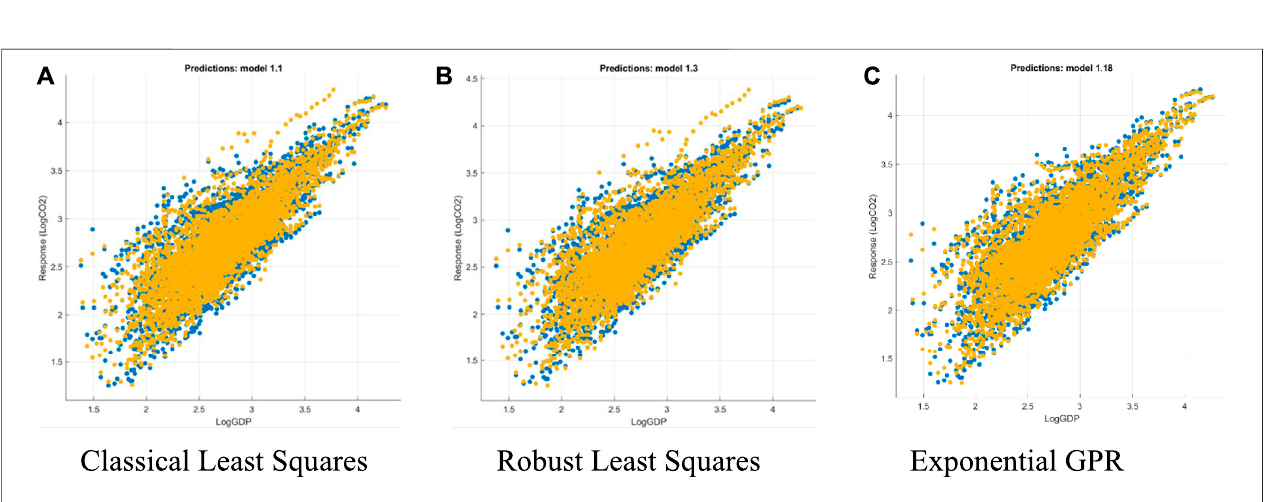
Frontiers in Energy Research |